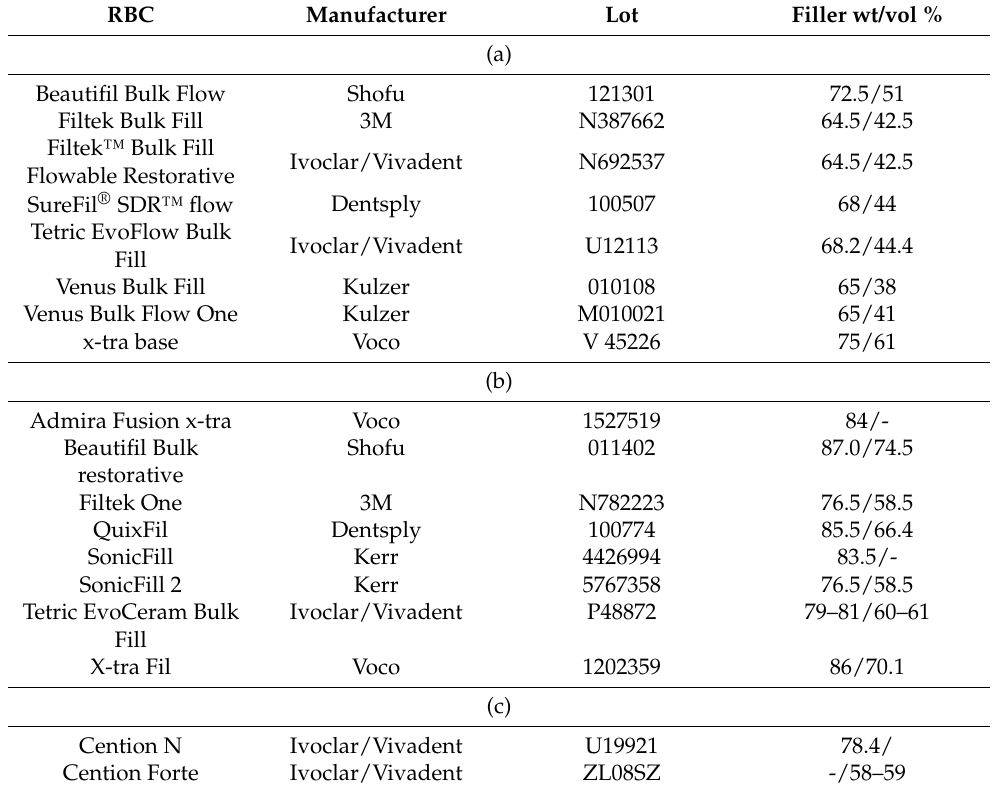
Table 1. Analyzed bulk-fill RBCs and amount of filler in volume (vol) and weight percent (wt) as reported by the manufacturer. (a) light-cured low-viscosity bulk-fill RBCs; (b) light-cured high- viscosity bulk-fill RBCs; (c) dual-curing bulk-fill